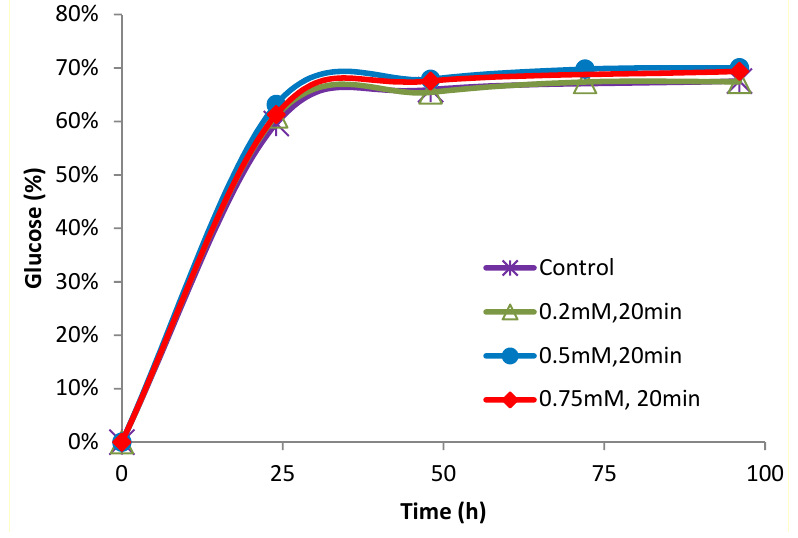
Figure 6. Glucose yield (based on glucan percent after pretreatment) during low ‐ solids enzymatic hydrolysis on washed solids.